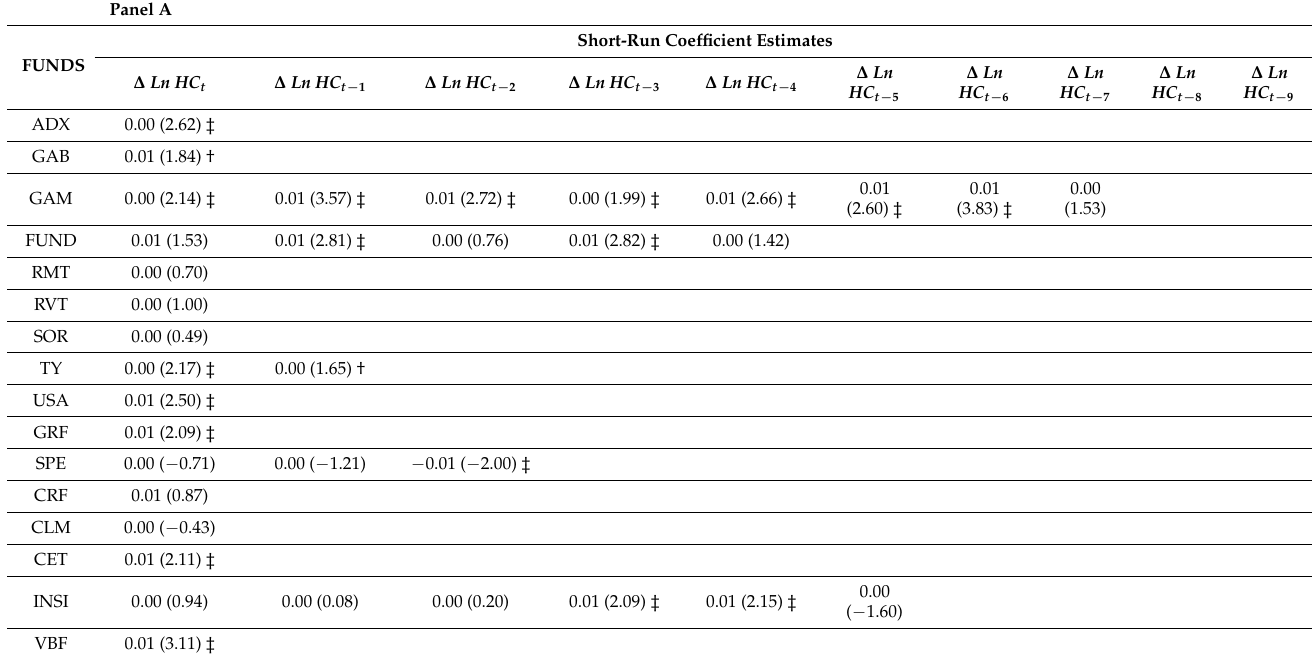
Table 6. Short-Run Coefficient Estimates—Linear ARDL—Model P = f (NAV,